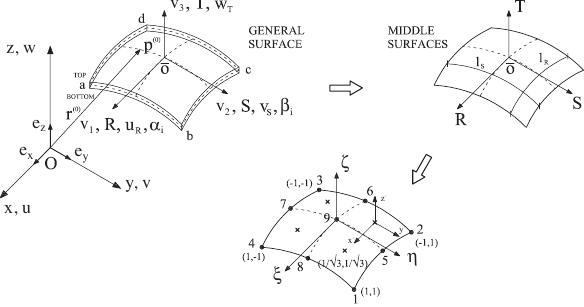
Figure 1: Geometrical description of the FE model in term of the real element and the discretization